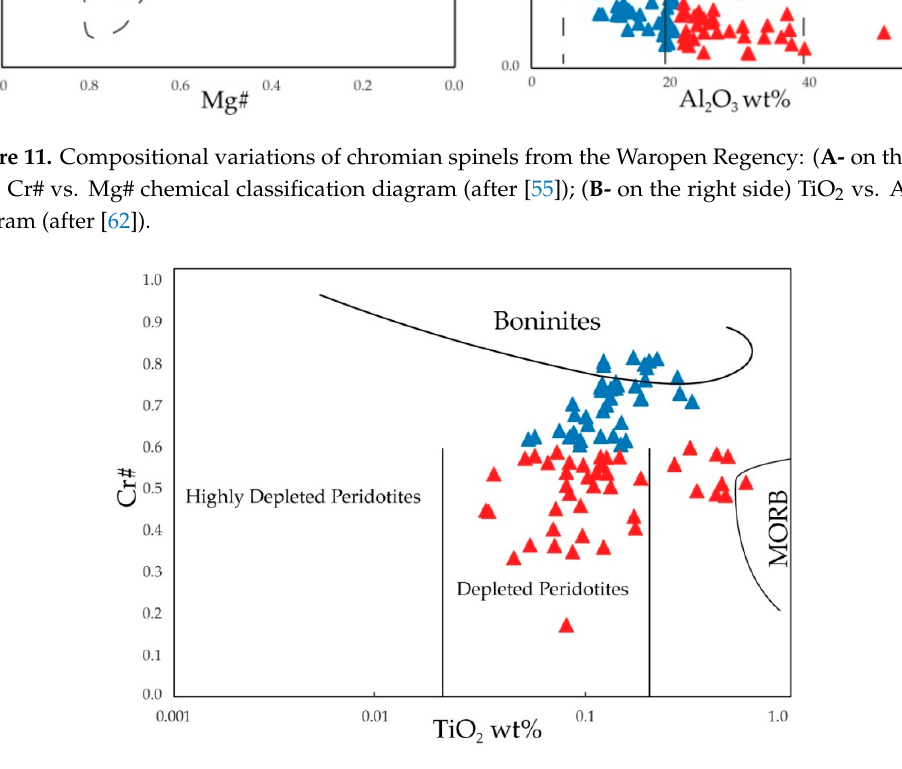
Figure 12. TiO 2 versus Cr# for chromian spinel (after [49,55,66]). Minerals 2020 , , x FOR PEER REVIEW